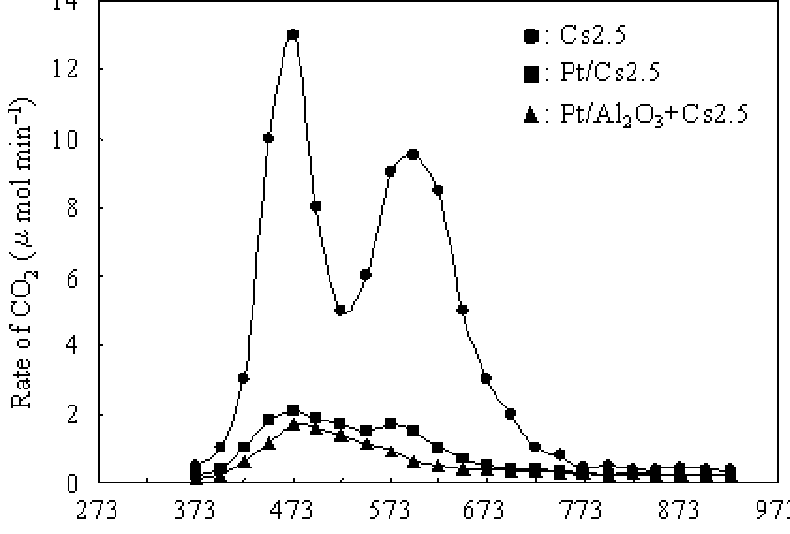
Figure 4. Dependence of the rate of CO calcination temperature over various catalysts after 5 h on stream at 573